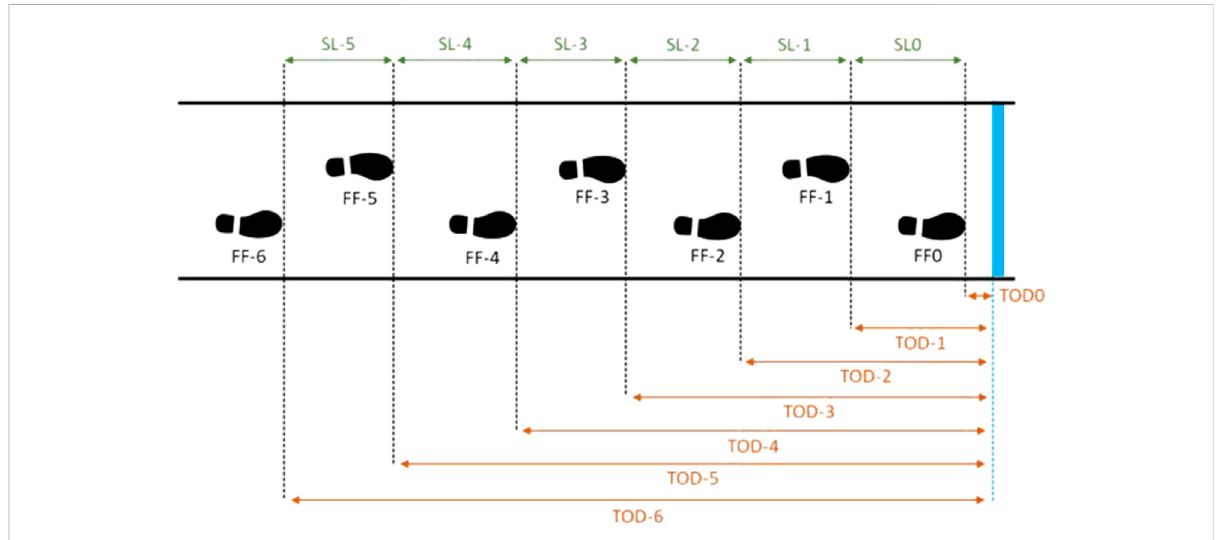
FIGURE 6 Schemaofgaitparameterscalculation duringthelocomotorpointingtask.Thebluelinerepresentsthetarget.Footfalli(FFi)coding:thefootfall of pointing is coded FF0. Step length (SLi) coding for each footfall i. Toe-obstacle distance (TODi) coding for each footfall